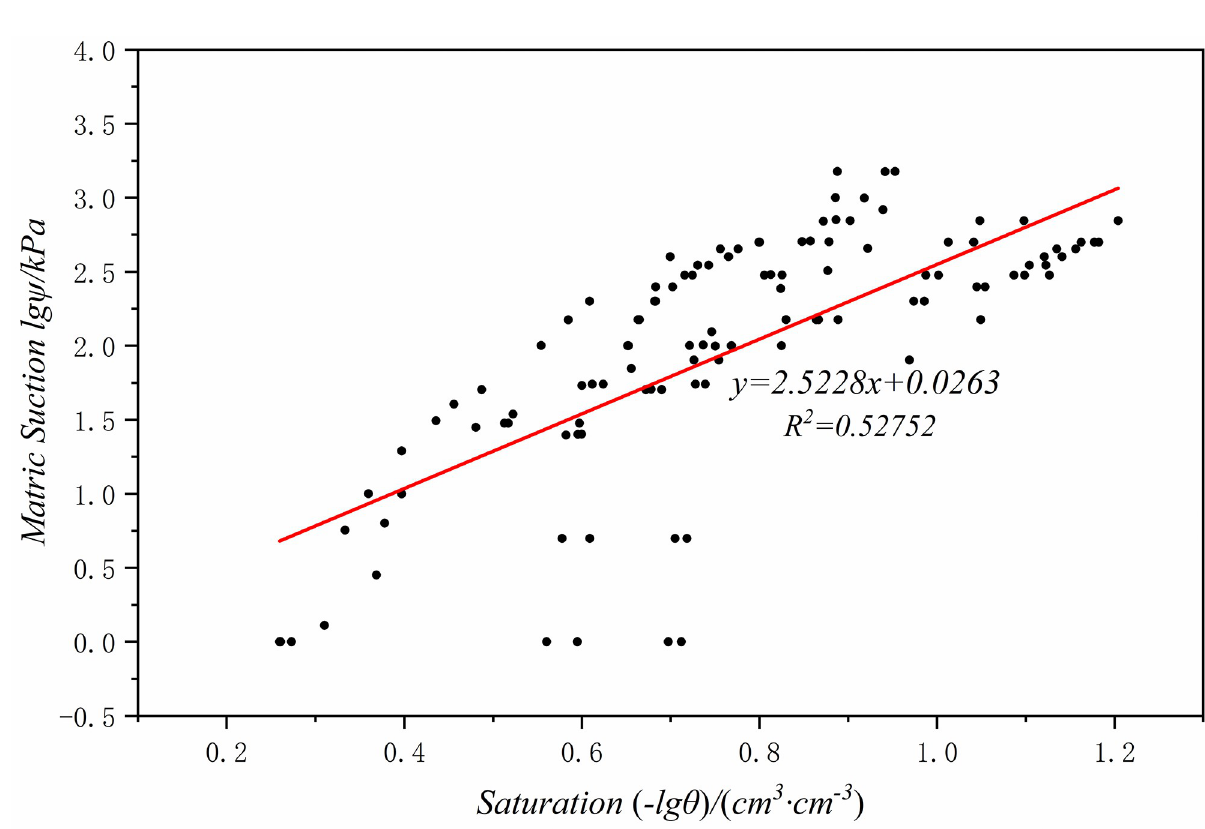
Fig 9. Clay loess(Zone III) degree of saturation and matric suction fitting result.